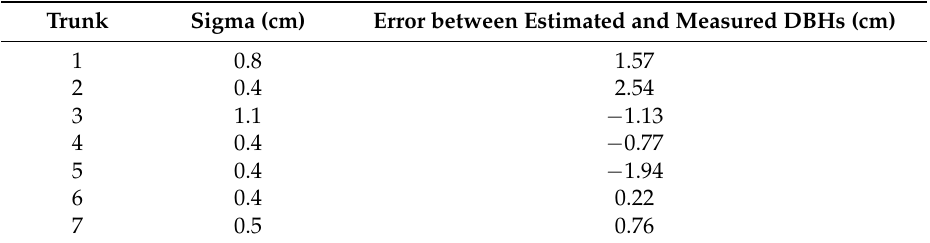
Table 3. Differences between the measured DBH and the DBH estimated by circle fitting. Trunk Sigma (cm) Error between Estimated and Measured DBHs (cm)